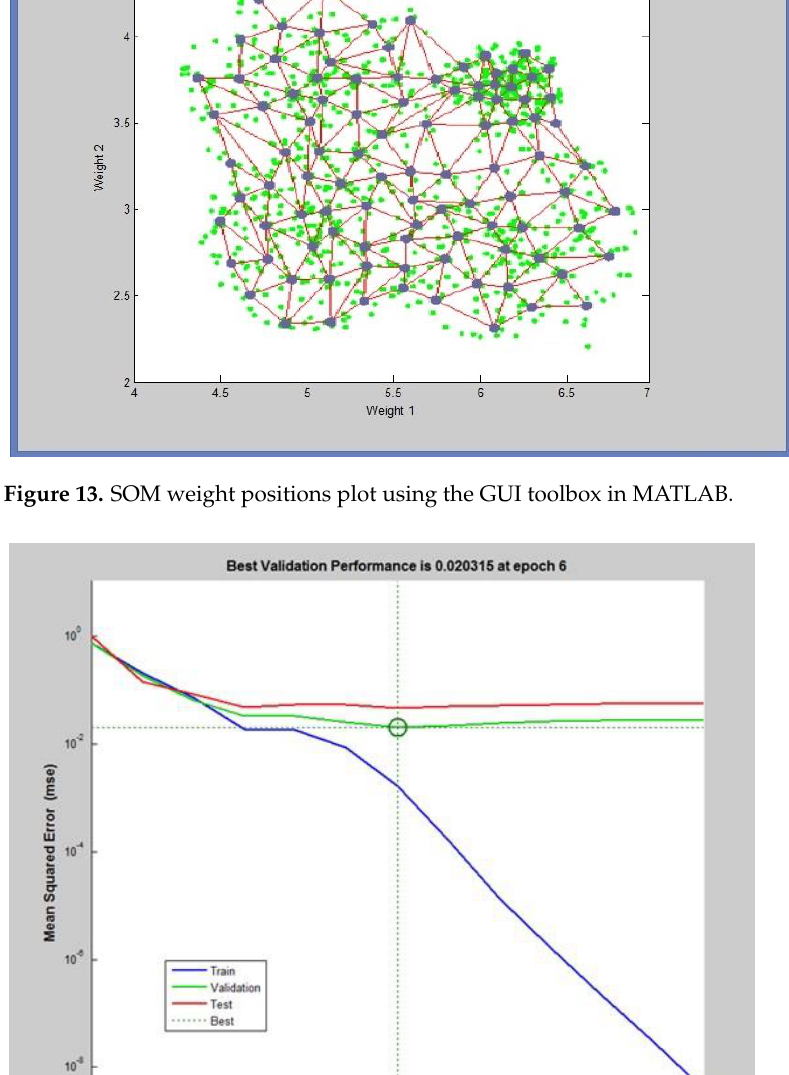
Figure 13. SOM weight positions plot using the GUI toolbox in MATLAB.